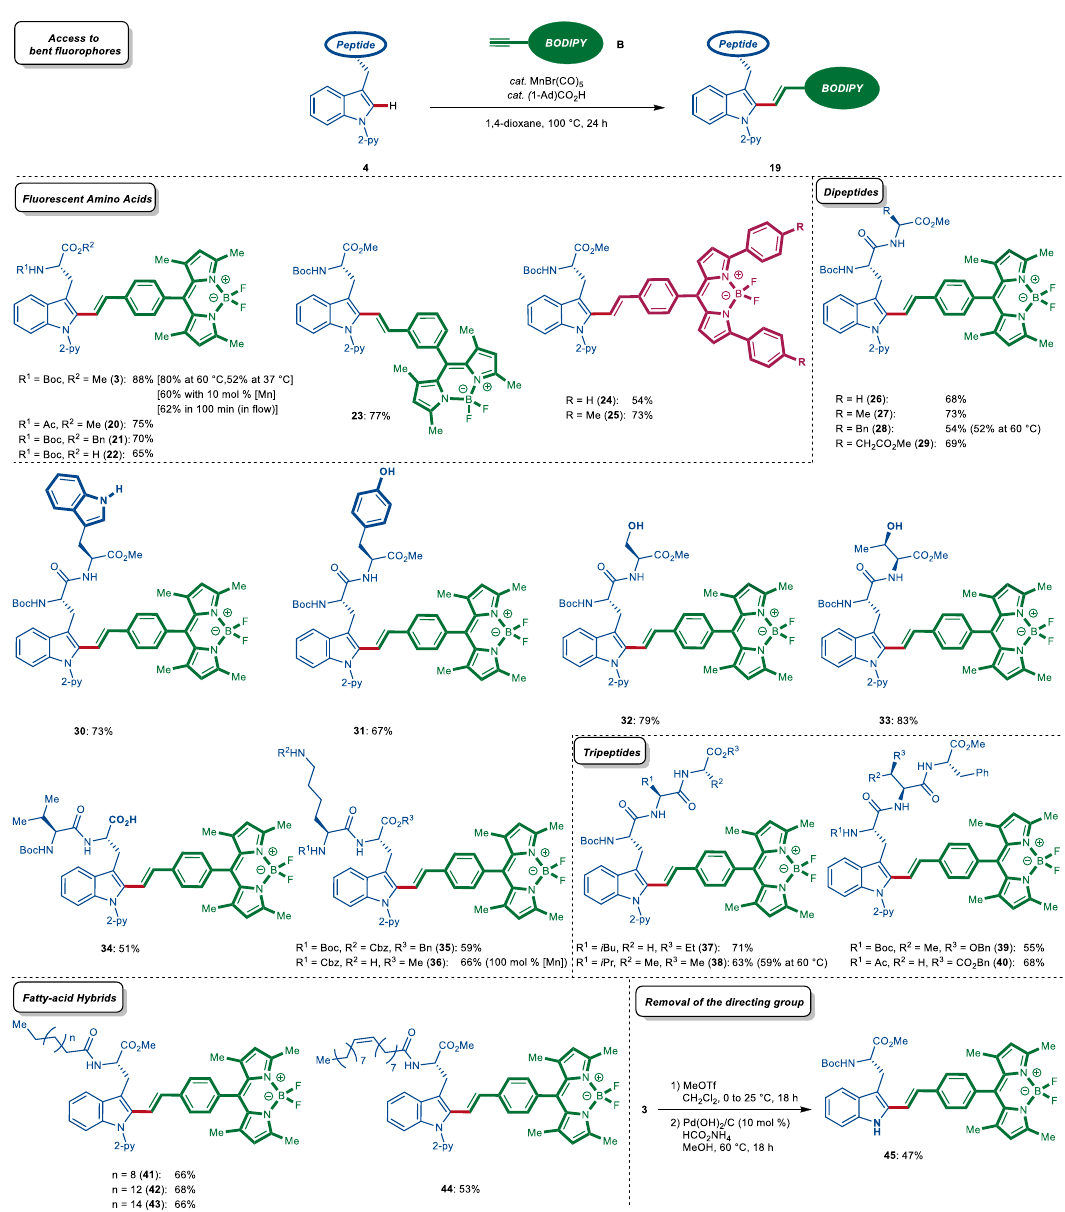
Fig. 3 Manganese-catalyzed fl uorescent labeling of small peptides via late-stage C – H stitching. Synthesis of peptides 20 – 45 featuring a bent linker between the BODIPY fl uorophore and the tryptophan amino acid via late-stage C – H